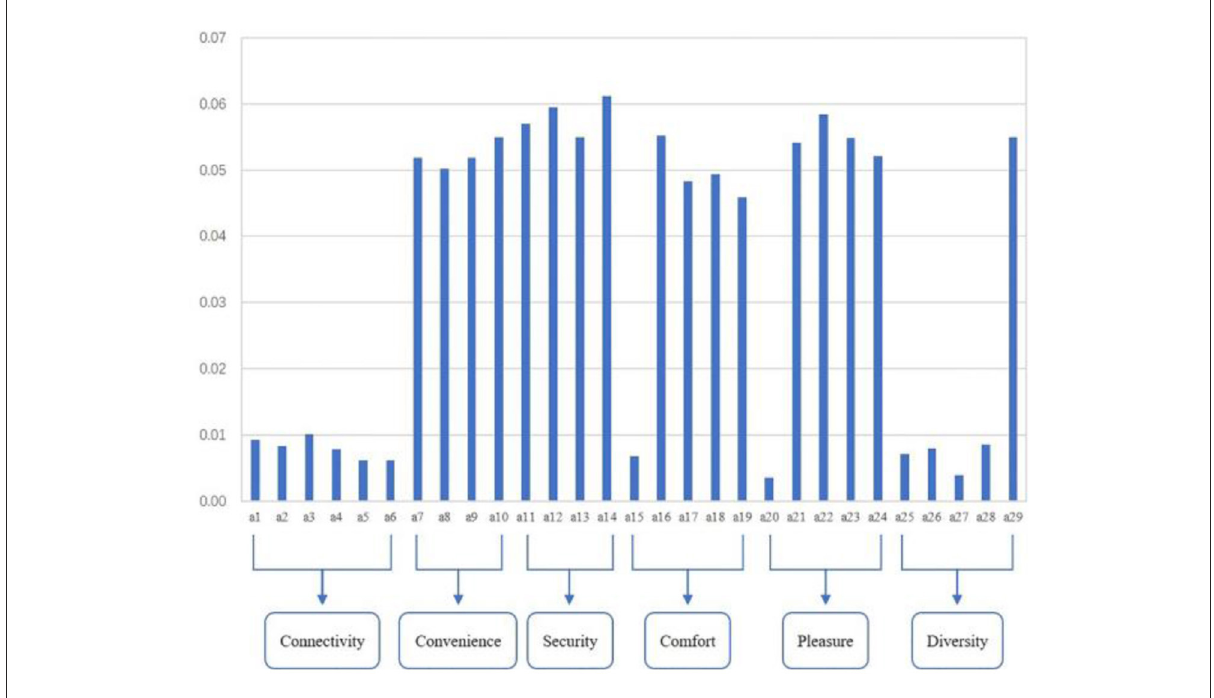
FIGURE4 Distribution of variable